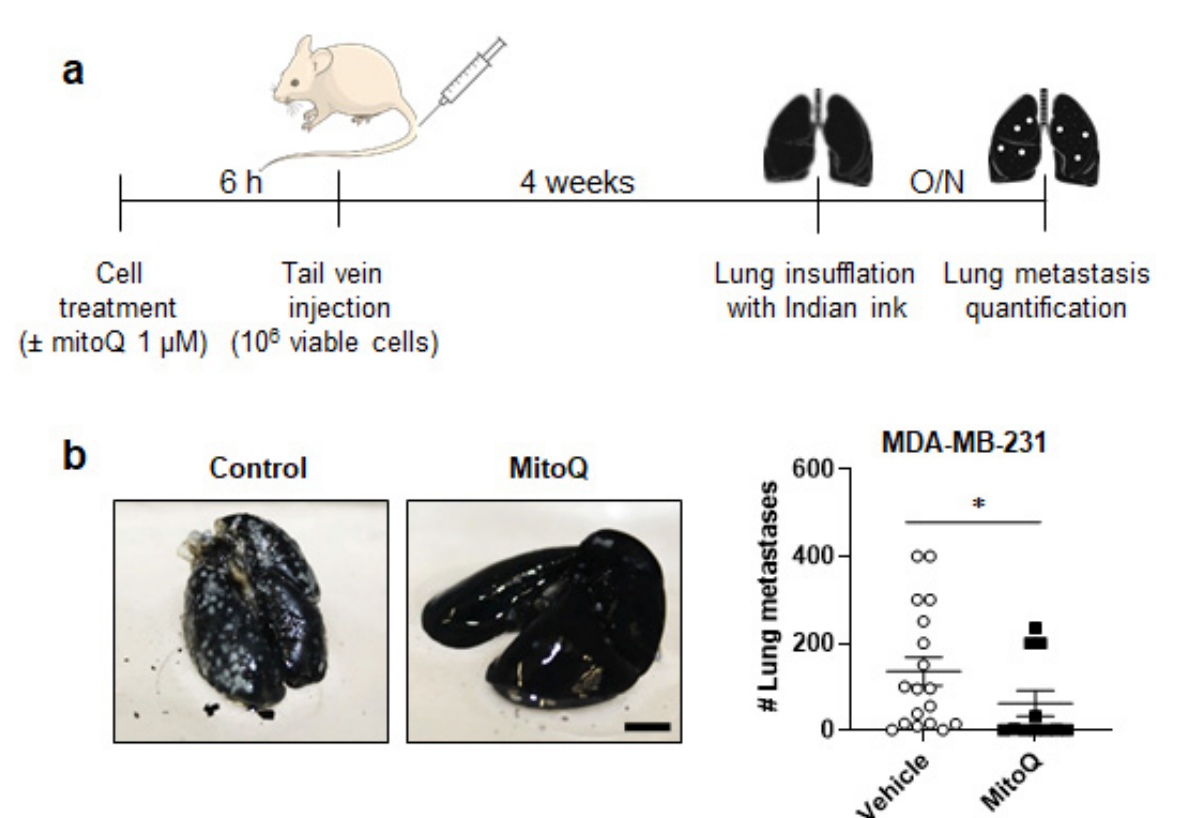
Figure 2. MitoQ inhibits the metastatic take of triple-negative human MDA-MB-231 breast cancer in mice. ( a ) Experimental protocol for tumor take assays where breast cancer cells were pretreated ± 1 µ M MitoQ for 6 h before tail vein injection of 10 6 viable cells in female NMRI nude mice. ( b ) Metastatic take of MDA-MB-231 human breast cancer cells in the lungs of mice using the protocol depicted in a . Left pictures are representative of lungs insufflated with Indian ink, where metastases appear as white dots quantified in the right graph (vehicle group n = 18; MitoQ group n = 11). Bar = 0.5 cm. All data are shown as means ± SEM. * p < 0.05 compared to vehicle, by Mann-Whitney test ( b ).